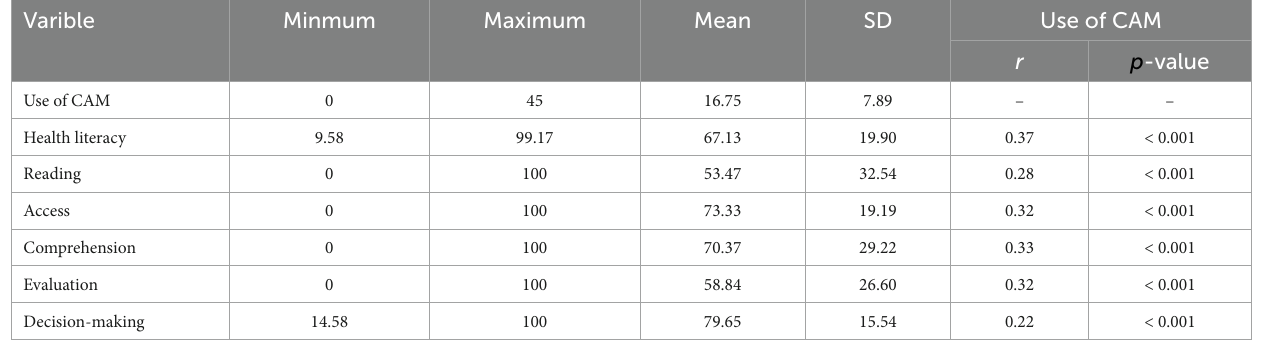
CAM, Complementary and Alternative Medicine; SD, Standard deviation; r, Pearson correlation.